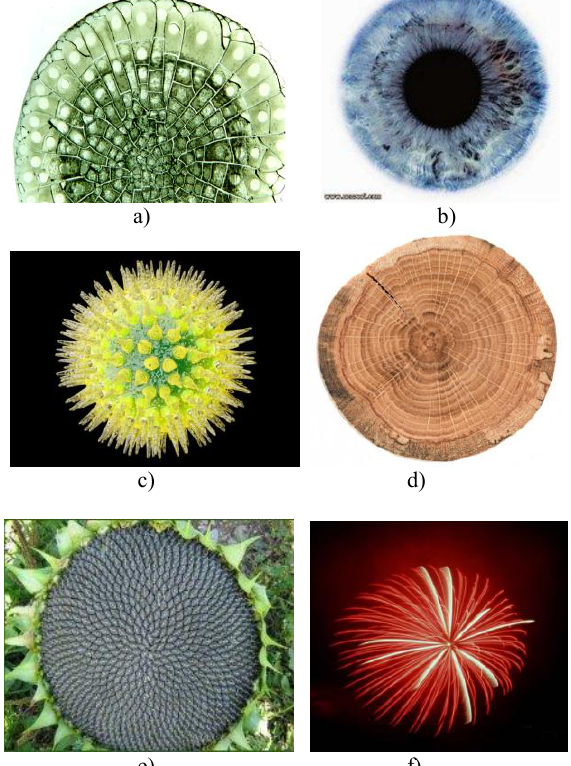
Figure 1. Examples of images with a radial-circular structure: a) facies, b) an eye, c) a virus, d) cut of a tree trunk, e) sunflower, f)